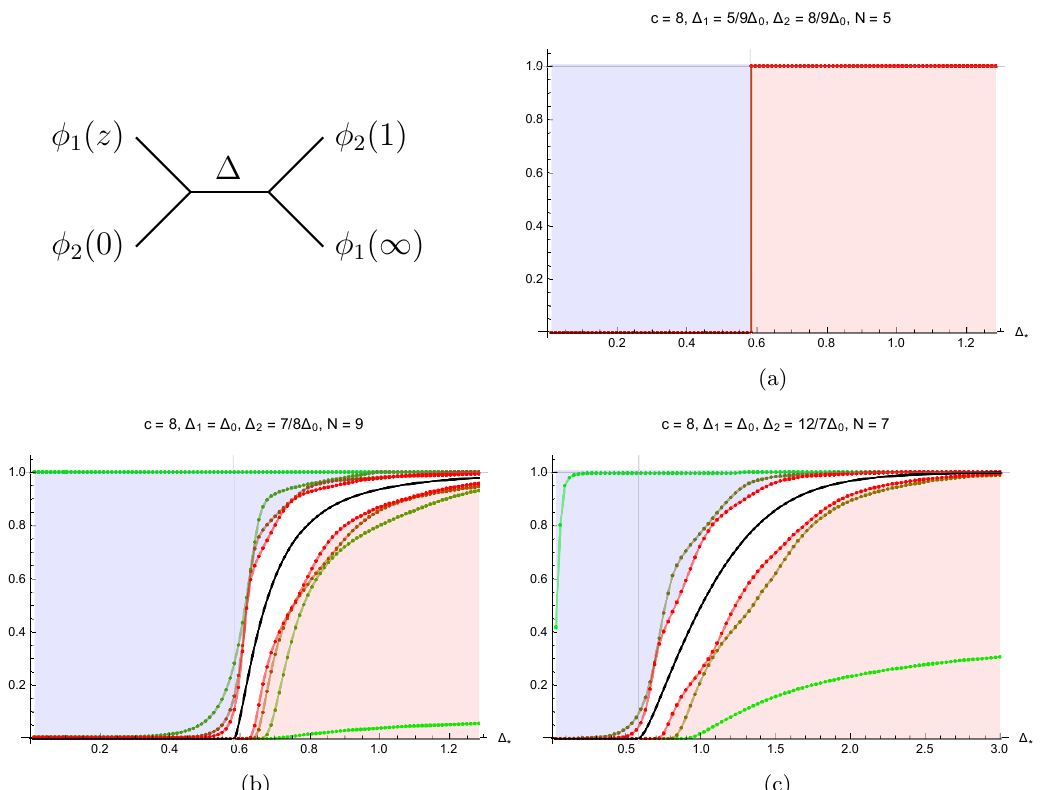
Figure 2 . Upper and lower bounds on the mixed correlator spectral function for c = 8 and ( (cid:1) 1 ; (cid:1) 2 ) = ( 5 ; 8 ) ; (1 ; 7 ) ; (1 ; 12 ). The black curve denotes the (analytically continued) DOZZ spec- (cid:1) 0 (cid:1) 0 9 9 8 7 tral function. In (c), a small gap of (cid:1) gap = 0 : 01 has been imposed to explicitly exclude the vacuum channel which would correspond to a singular conformal block for the mixed